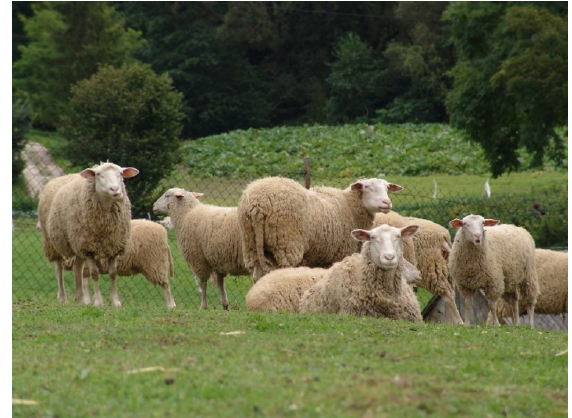
Figure 1. Olkuska sheep breed (photo by Jacek Sikora).